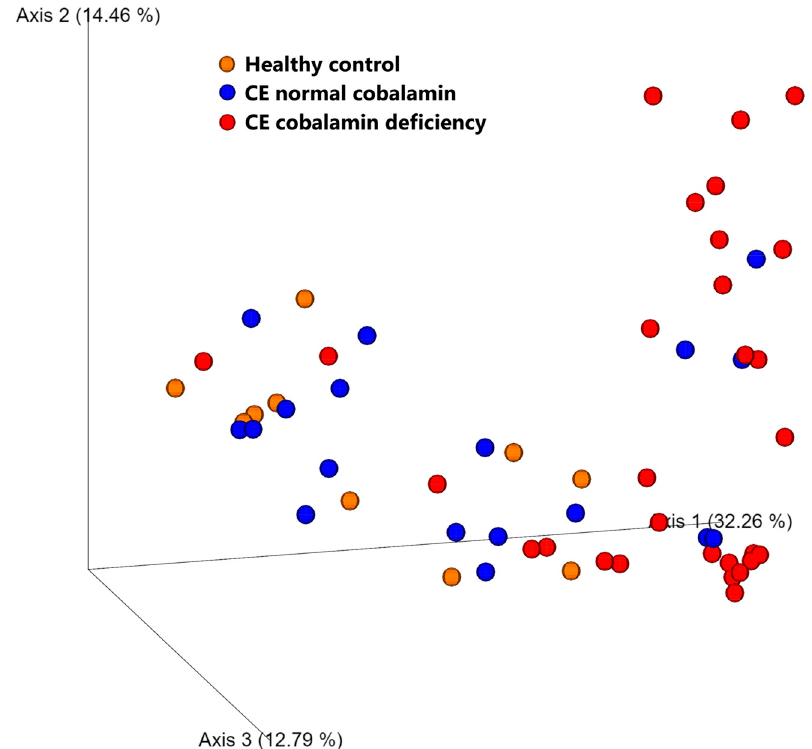
Figure 2. PCA plot of weighted UniFrac distances (beta diversity) of baseline fecal samples from dogs with CE, color-coded based on cobalamin levels (red dots–cobalamin deficient, blue dots– normocobalaminemia), compared to healthy controls (orange dots). Samples from cobalamin- deficient dogs clustered separately from those from normocobalaminemic and healthy dogs. No significant difference was observed between samples from CE dogs with normocobalaminemia and healthy